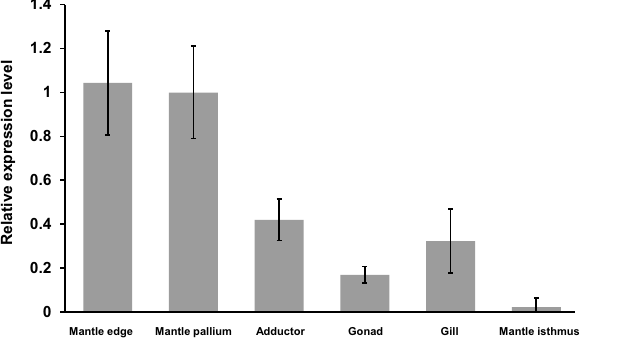
Figure 3. Relative gene expression levels of NU-5 in each tissue of P. fucata . Real-time quantitative PCR (qPCR) was performed to evaluate relative gene expression levels compared with the mantle pallium. The values are relative to that of the mantle pallium. Data are expressed as the mean ± S.E. ( n =